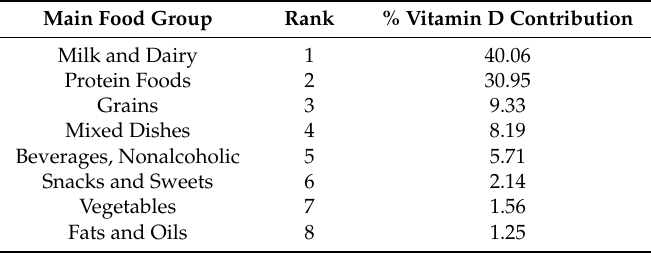
Table 5. Food sources of vitamin D (D2 + D3) contribution in the total U.S. diet, adults ≥ 51 years old ( n = 4522; gender combined; daily intake data; NHANES 2011–2014; DFE = dietary folate equivalents; main food groups contributing <1.0% not reported; data are Day 1